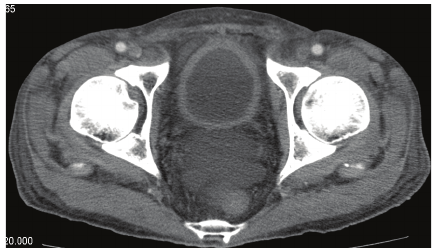
Figure 2: CT scan reveals bladder wall